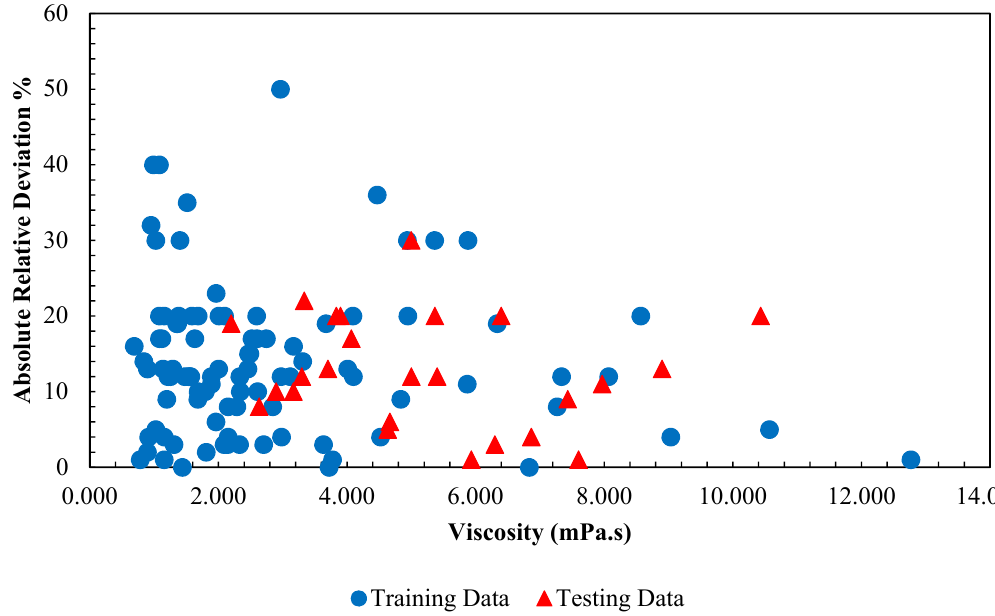
Figure 12. Comparison between actual viscosity of (cid:1832)(cid:1857) (cid:2870) (cid:1841) (cid:2871) /ethylene glycol ‐ water nanofluid and predicted values by PSO ‐ ANN model versus relevant data index.